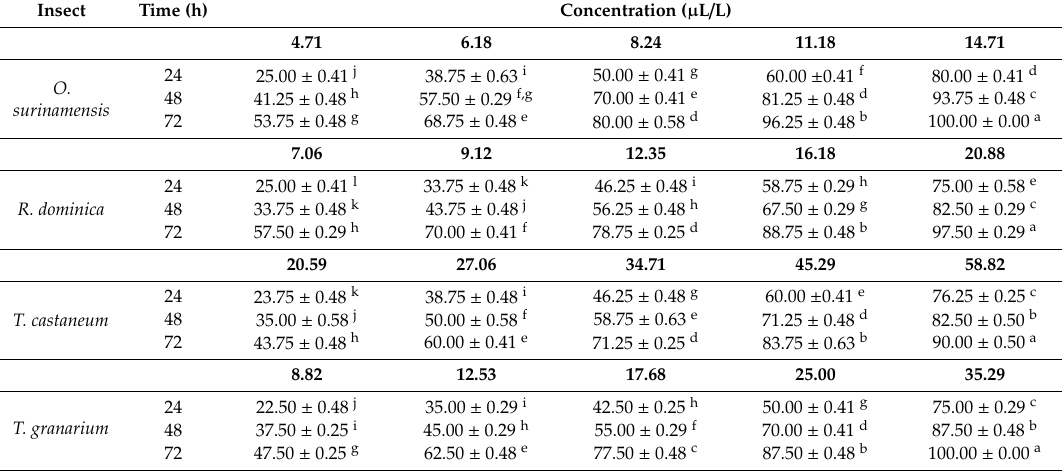
Table 2. Mean mortality ± SE of the adults of Oryzaephilus surinamensis , Rhyzopertha dominica , Tribolium castaneum , and Trogoderma granarium exposed to the fumigation of Satureja intermedia essential oil after 24, 48, and 72 h.